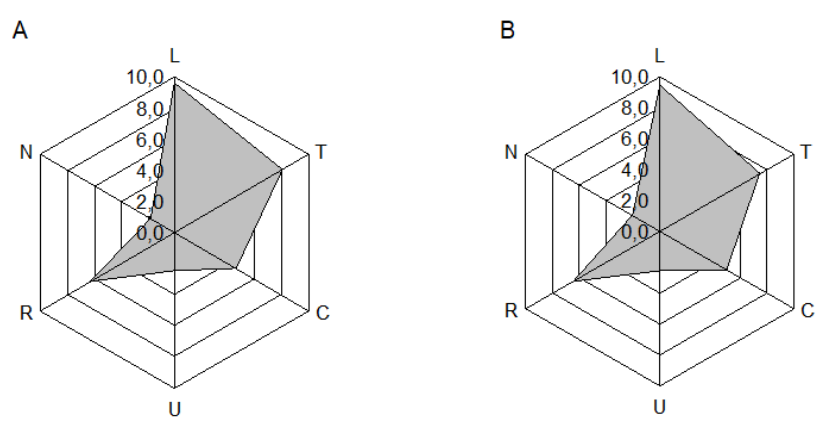
Figure 6. Ecograms of the Satureja montana garrigues in Ionian Arc (A) and in Alta Murgia